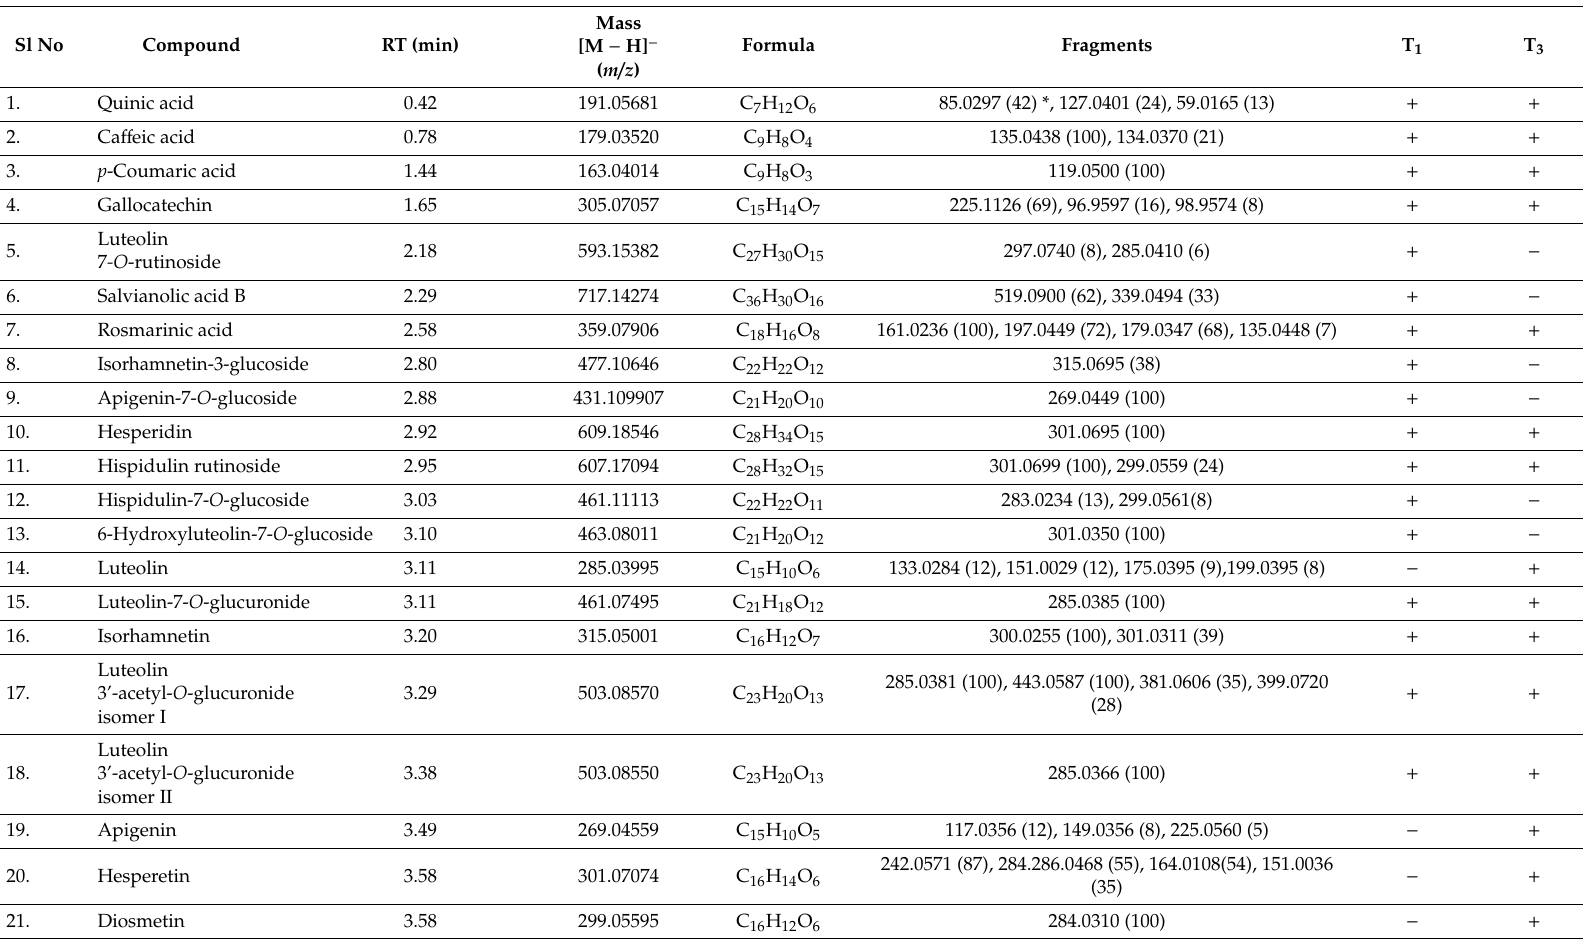
Table 2. Bioactive compounds in fresh tissue homogenization (T 1 ) and its fermentation (T 3 ) of Rosmarinus o ffi cinalis identified by